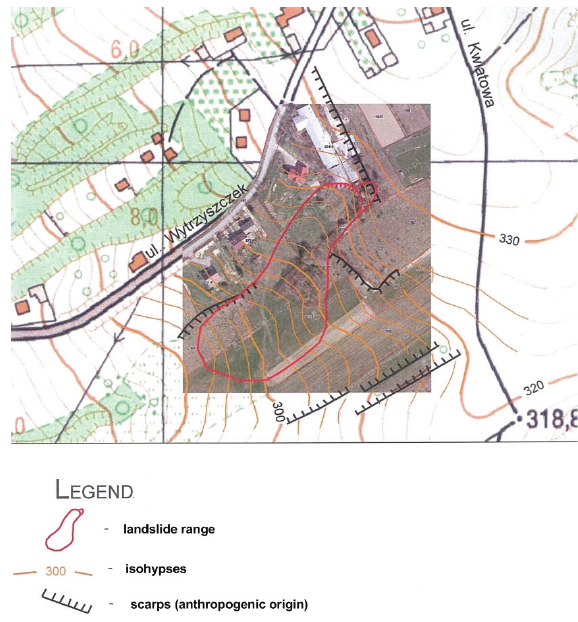
Fig. 1. Location map of the fragment of landslide in